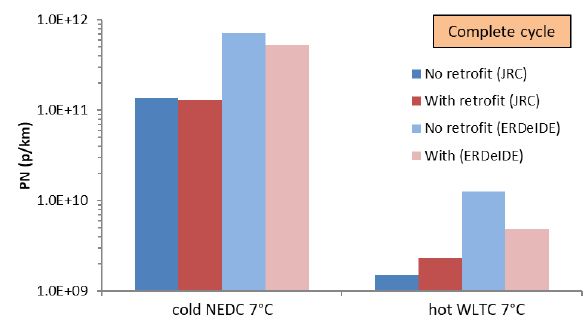
Fig. 4. PN results for the complete cycles